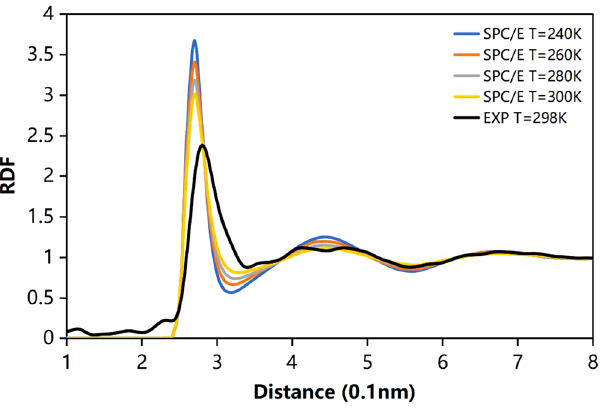
Figure 2. The radial distribution function (RDF) of oxygen–oxygen at various